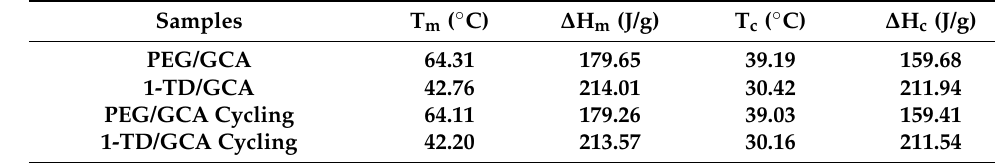
Figure 5. DSC curve of ( a ) the PEG/GCA composite and ( b ) DSC 100 cycling test. ( c ) FTIR peaks after 100 cycles. DSC curve of ( d ) 1-TD/GCA composite and ( e ) DSC 100 cycling test. ( f ) FTIR peaks after 100 cycles. Table 2. DSC results of the PEG/GCA and 1-TD/GCA composites. Table 2. DSC results of the PEG/GCA and 1-TD/GCA composites.